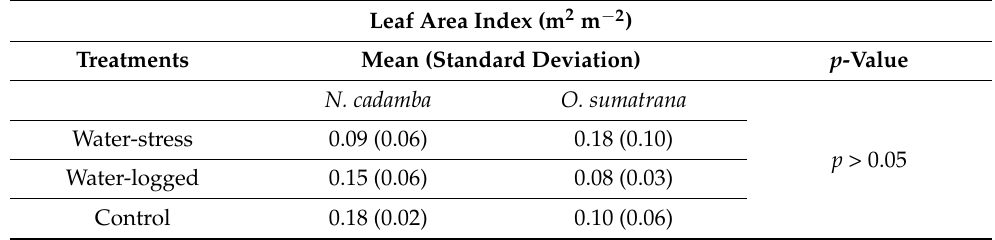
Table 4. Mean values of leaf area index (m 2 m − 2 ) of N. cadamba and O. sumatrana seedlings under different treatments ( n = 3) were not significantly different ( p > 0.05) using two-way ANOVA followed by Tukey’s HSD post